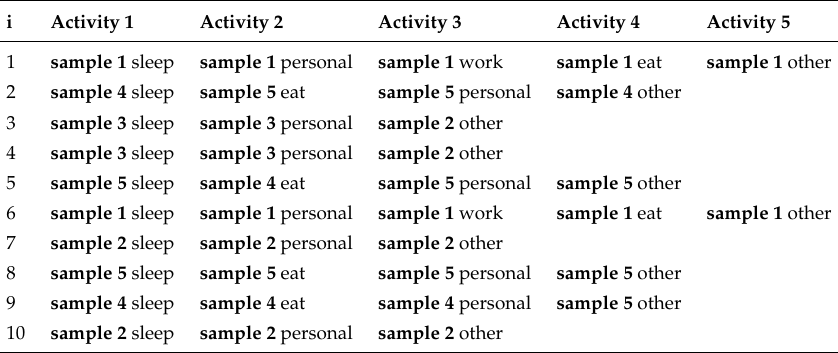
Table 3. Ten replicated copies based on the samples from Table